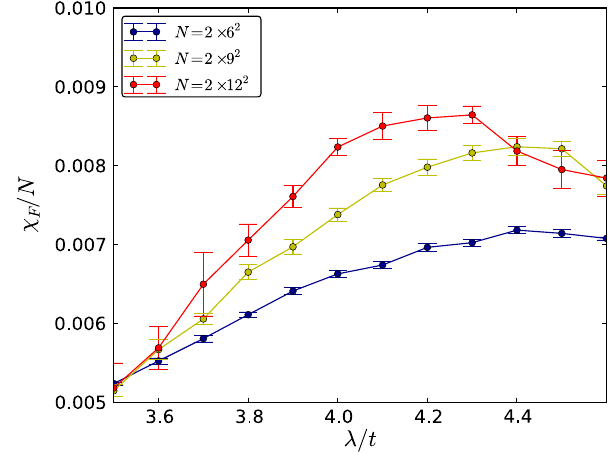
FIG. 6. Fidelity susceptibility per site of the Hubbard model on the honeycomb lattice Eq. (26) with N ¼ 2 L 2 sites.